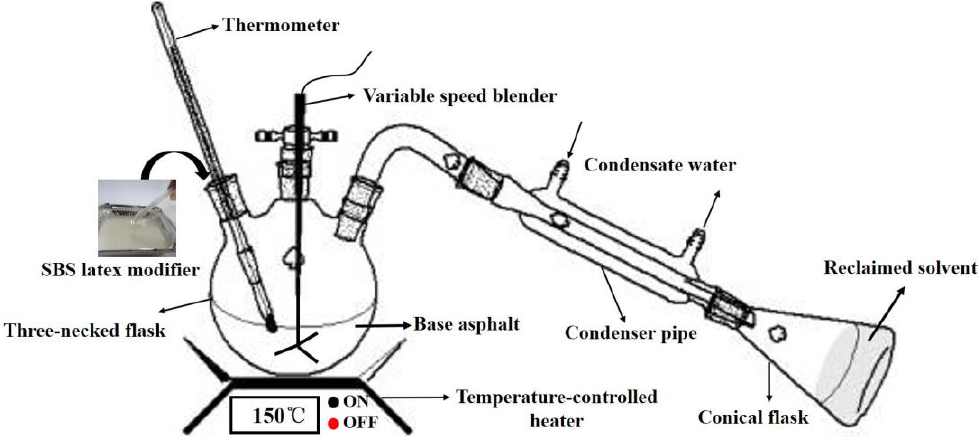
Figure 2. The preparation process of styrene-butadiene-styrene (SBS) latex-modified asphalt.